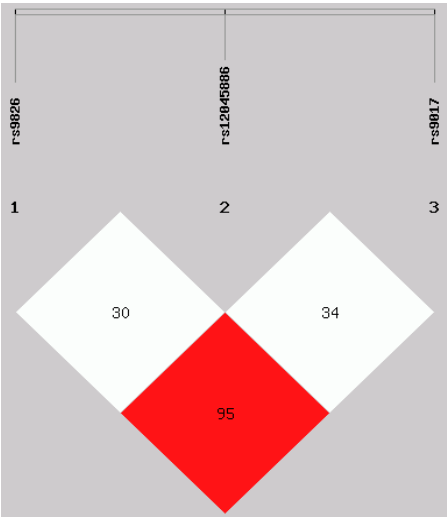
Figure 2. Linkage disequilibrium (LD) plots of three SNPs in the RORc2 gene. The plot illustrates pairwise LD between all polymorphisms based on D ′ values. Values approaching zero indicate absence of LD, and those approaching 100 indicate complete LD. The square colored red represent varying degrees of LD < 1 and LOD (logarithm of odds) > 2 scores (strong LD) and white blocks represent varying degrees of LD < 1 and LOD < 2 scores (weak LD).